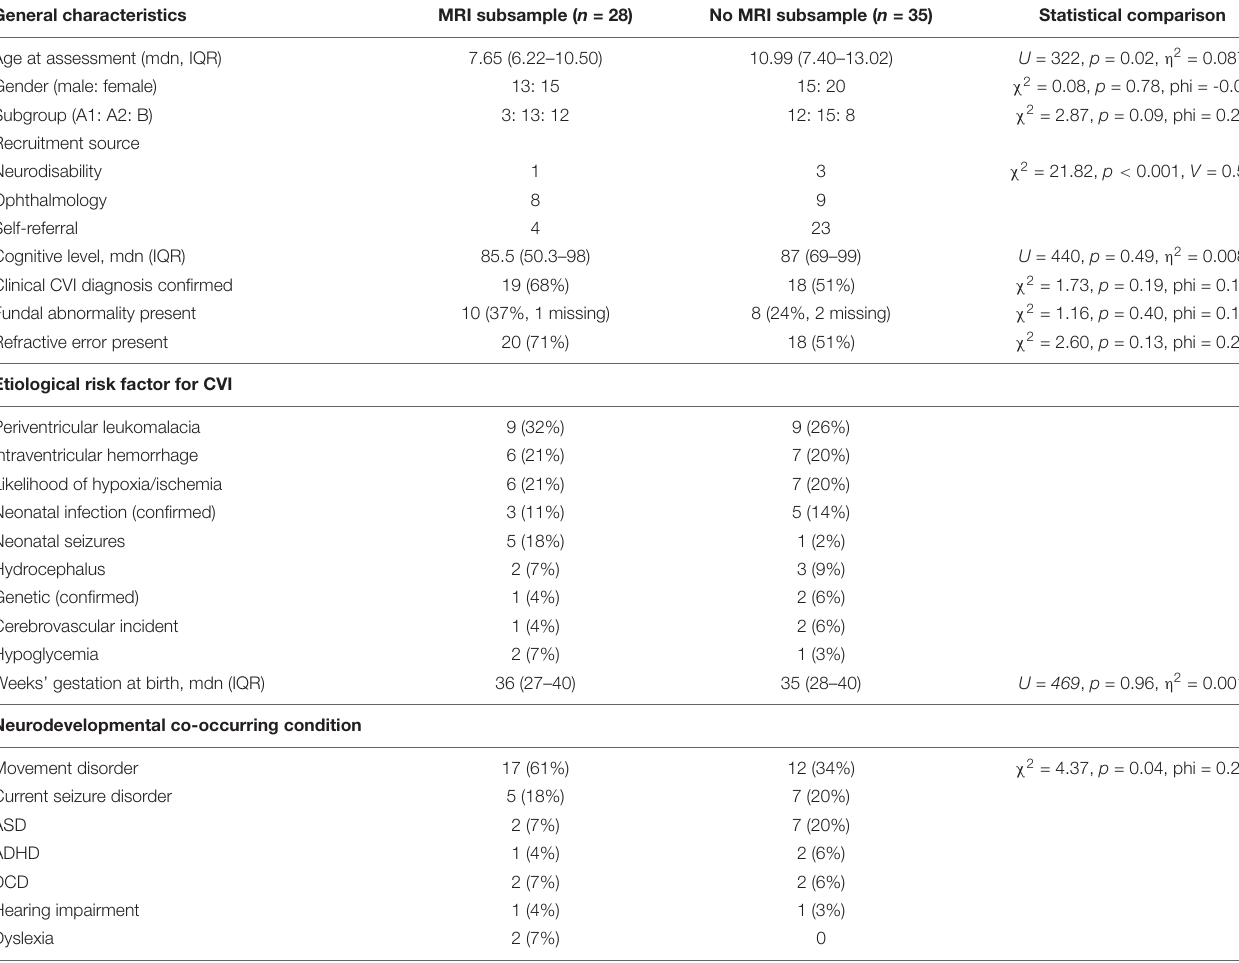
TABLE 1 | Descriptive characteristics of the study sample. General characteristics MRI subsample ( n = 28) No MRI subsample ( n = 35) Statistical